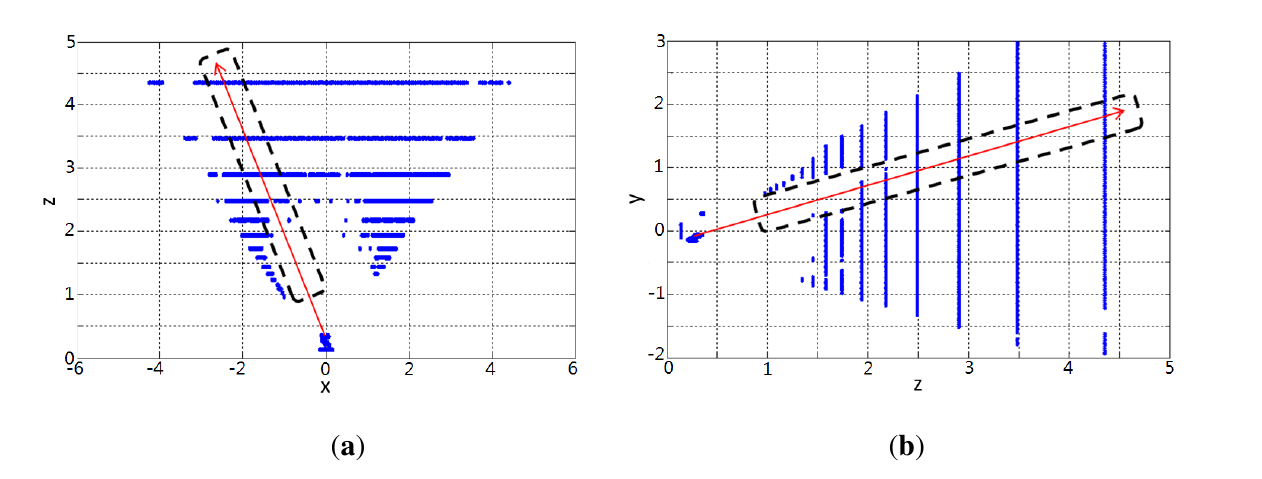
Figure 7. Virtual rectangles used as a classifier on ( a ) the x-z plane and ( b ) the y-z